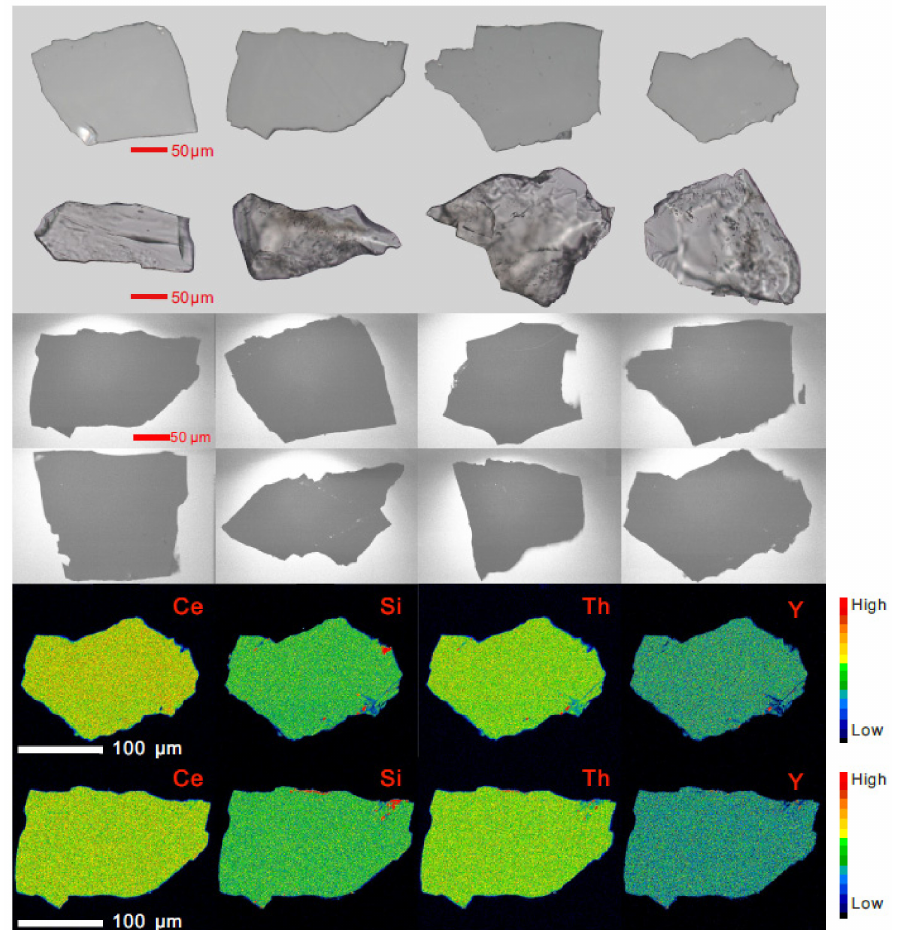
Figure A1. Reflected, transmitted, cathodoluminescent (CL), and X-ray images of the RW-1